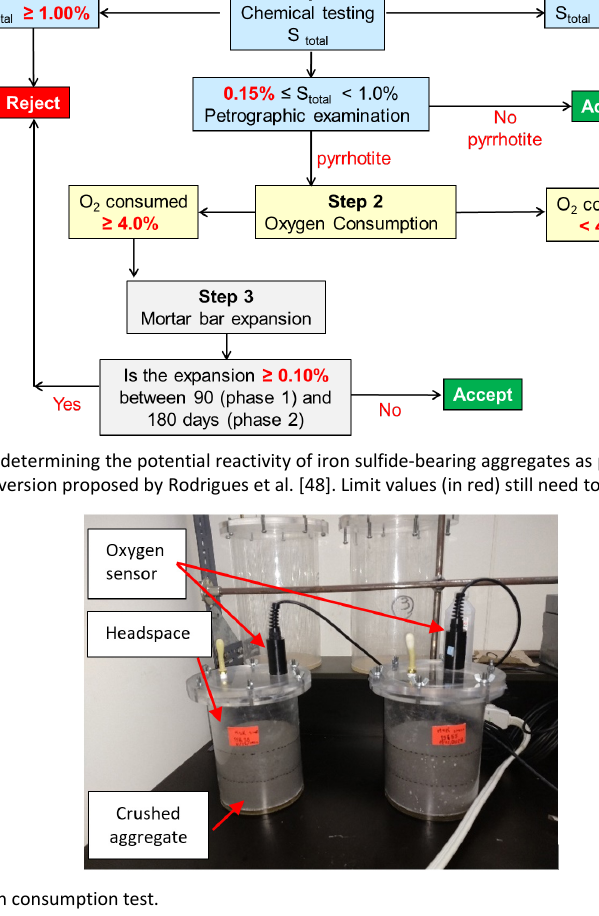
Figure 6. Cells used in the oxygen consumption